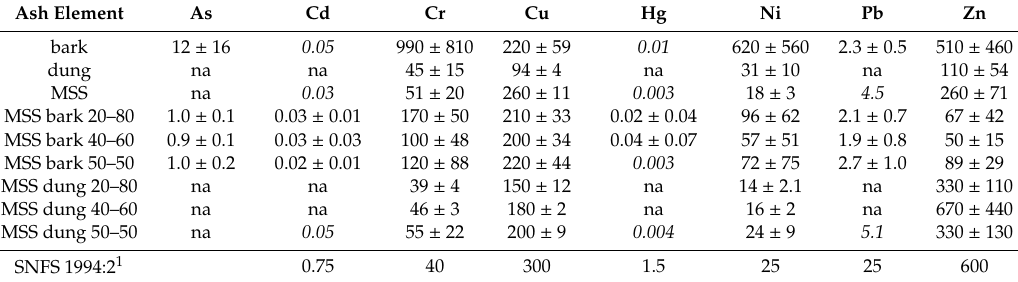
Table 4. Calculated concentrations from Table 3 of selected trace elements in ashes from laboratory-scale experiments given as g*(ha, year) − 1 , calculated on a maximum supply of 22 kg P (ha, year) − 1 . The result is presented as mean values with sample standard deviations (n = 2 − 9). Values in italics are based on single data